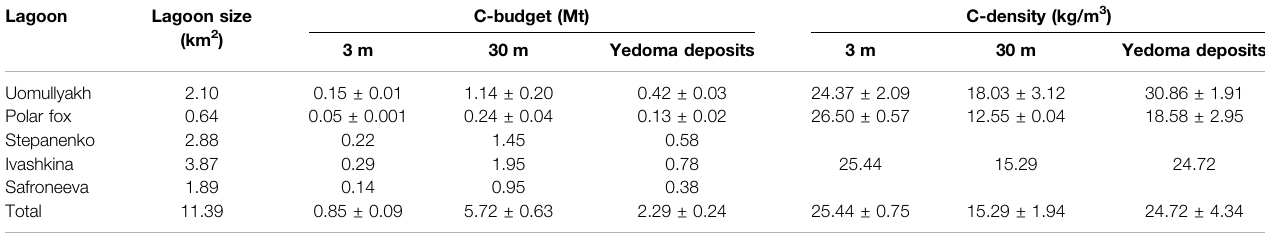
TABLE 2 | Calculated carbon pools for the upper 3 m and 30 m deposits below Uomullyakh and Polar Fox lagoons and estimated carbon pools below the three additional thermokarst lagoons of the southern Bykovsky Peninsula. Calculation is based on the bootstrapping method. The C-density of Stepanenko, Ivashkina and Safroneeva lagoons is the mean of the C-density calculated for Uomullyakh and Polar Fox lagoons.